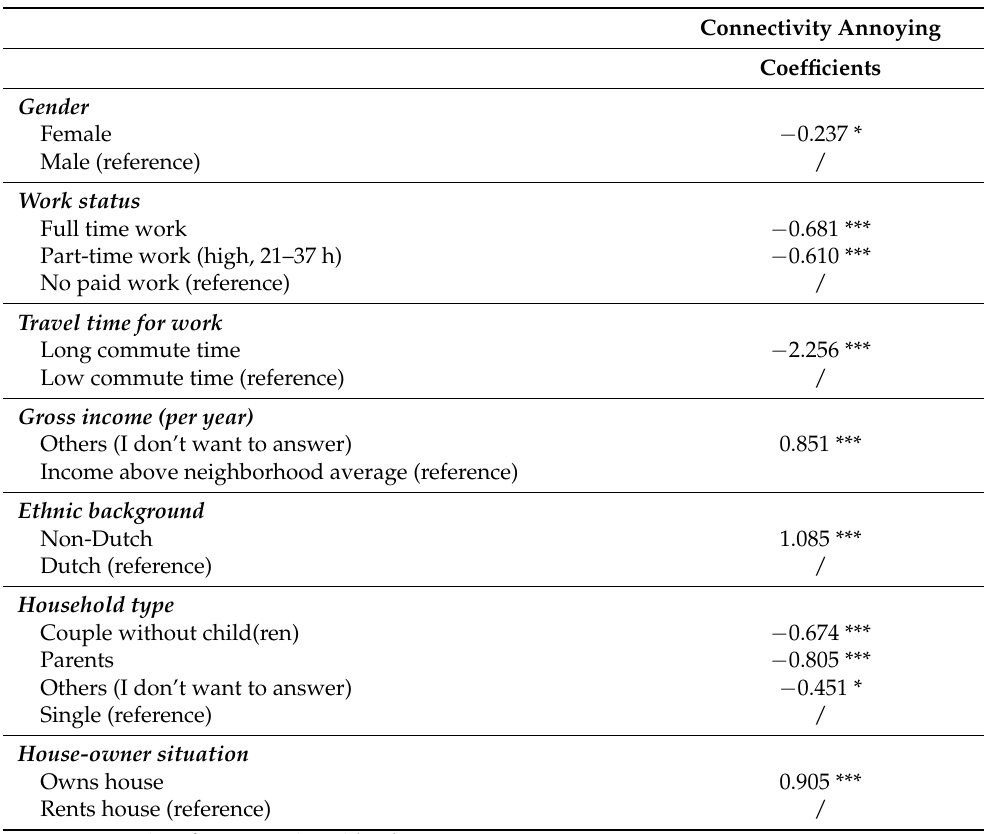
Table 11. Results of the MNL models ( annoyance sense